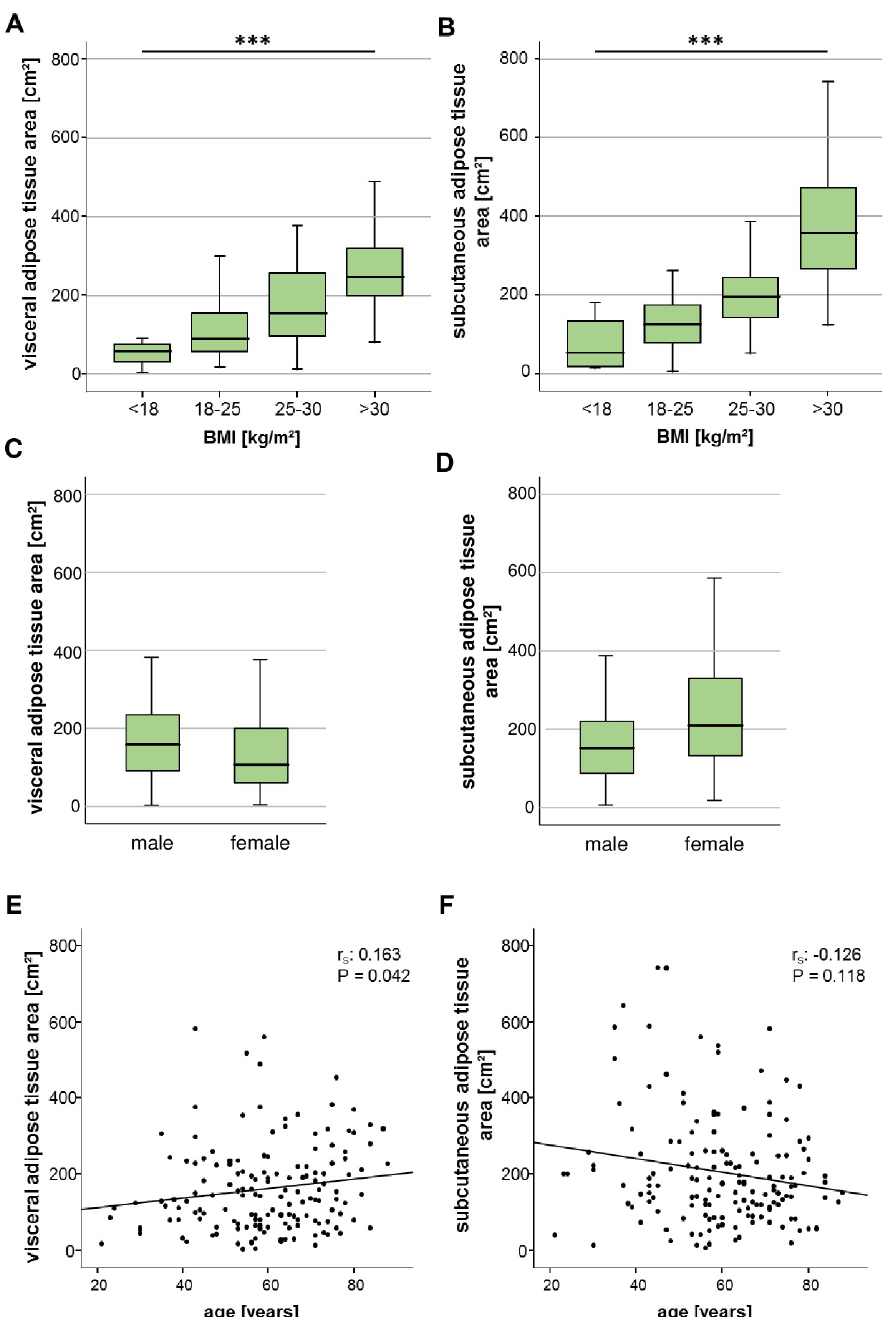
Fig 2. The ICU patients’ visceral and subcutaneous adipose tissue areas correlate with BMI and differ between the genders. (A, B) Both VAT and SAT areas are closely associated with the clinical categories of the patients´ body mass index (BMI). (C) Female ICU patients are characterized by a significantly smaller VAT area compared to male patients, whereas the SAT area is increased in female compared to male patients (D). (E) The patients´ age positively correlates with the VAT area but not the area of the SAT (F). Data are expressed as correlation analyses including Spearman´s rho coefficient (A, B, E, F) or means ± SEM (C, D); � p < 0.05, p ��� < 0.001.